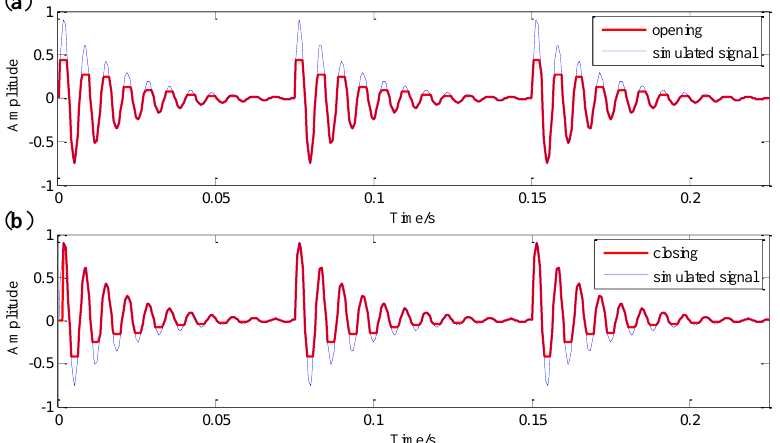
Figure 3. Filtering result of opening operator and closing operator: ( a ) opening and ( b ) closing.